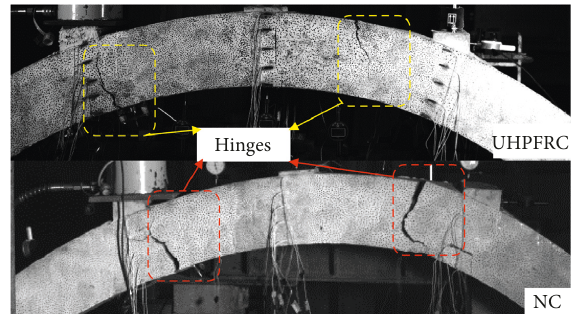
Hinges NCUHPFRC Figure 5: Failure patterns for UHPFRC and NC